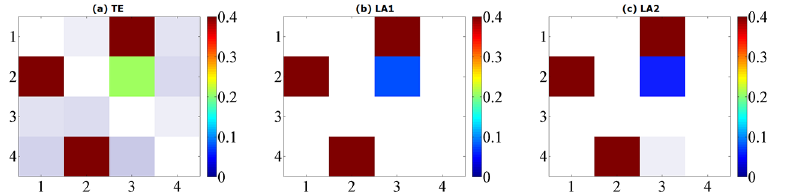
Fig 1. Matrix representations of the corresponding causalities for Model A. Retrieved by traditional TE method (a) and two low-dimensional approximation methods (b) (c) with linear estimator. The results are averaged over 100 simulations of 1024 time points and shown with color revealing the magnitude and transparency indicating the significance. The directions of causal influence are from row to column.